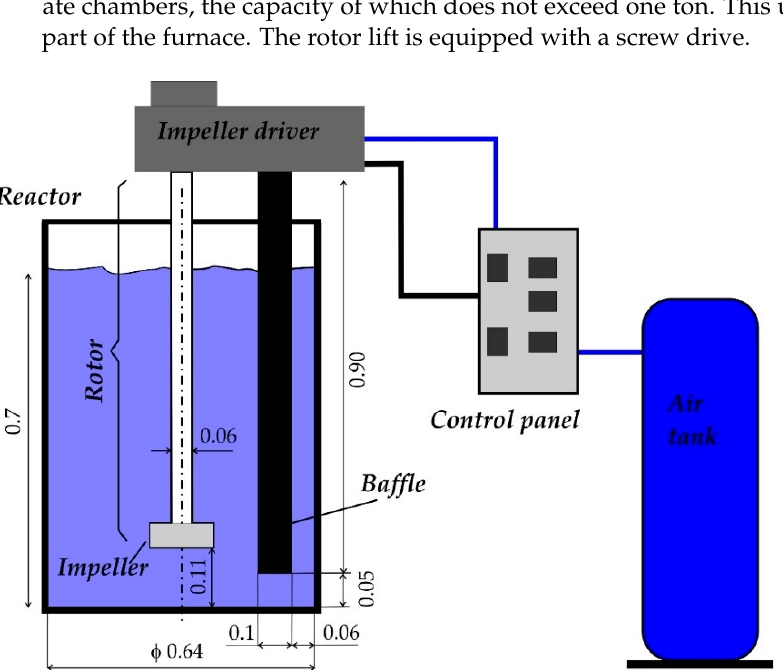
Figure 5. A schematic of the water model of reactor URO